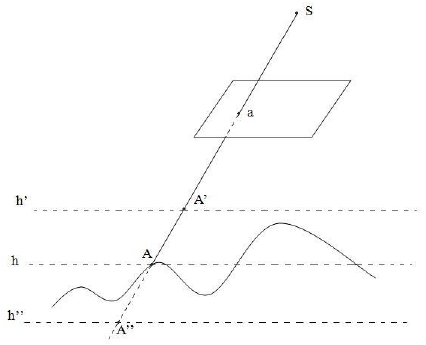
Figure 4. Illustration of the direct georeferencing